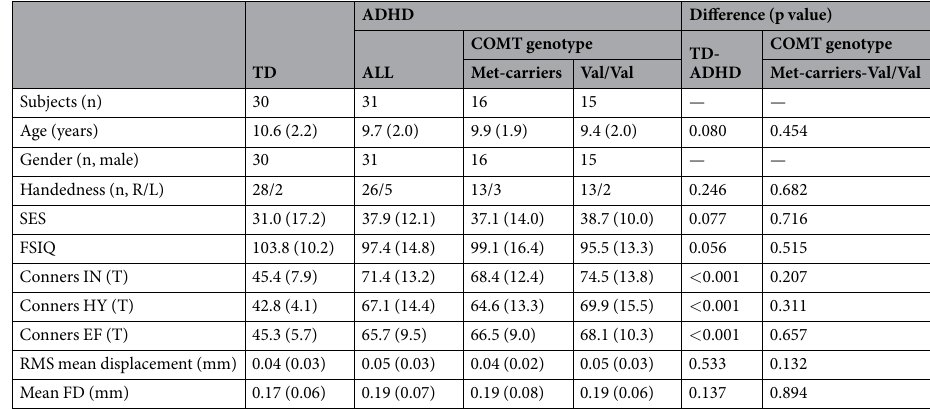
Table 1. Demographic data of the participants. ADHD, attention-deficit/hyperactivity disorder; TD, typically developing; COMT, catechol-O-methyltransferase; SES, socioeconomic status; FSIQ, full scale intelligence quotient; IN, inattention; HY, hyperactivity/impulsivity; EF, executive function; T, T-score; RMS, root mean square; FD, frame-wise displacement.